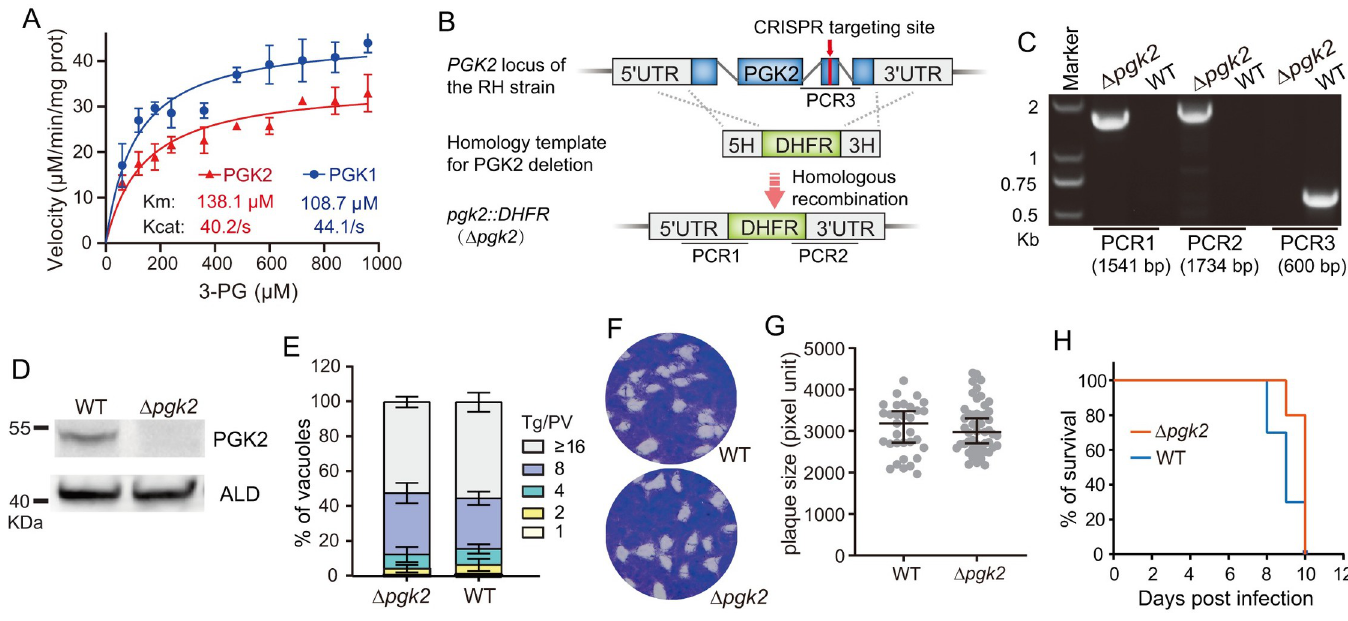
Fig 2. PGK2 is dispensable for T . gondii growth. A, comparison of the enzymatic activities of T . gondii PGK1 and PGK2, assayed with recombinant enzymes under different concentrations of 3-phosphoglycerate (3-PG). Means ± SD of three independent experiments were plotted. B, schematic illustration of PGK2 deletion by CRISPR/Cas9 directed homologous gene replacement with the selection marker DHFR . 5H and 3H denote the two homologous arms for recombination. PCR1/2/3 are amplification products for PGK2 deletion mutant ( Δ pgk2 ) identification. C, diagnostic PCR on a Δ pgk2 clone. D, Western blotting confirms the absence of PGK2 expression in the Δ pgk2 mutant. ALD was included as a loading control. E, comparison of the intracellular replication rates of the wildtype (WT) and the Δ pgk2 mutant, as determined by the distribution of the number (1, 2, 4, 8, � 16) of Toxoplasma parasite per PV (Tg/PV). Means ± SEM of three independent experiments, each with three replicates. More than 120 PVs were analyzed for each strain in each experiment. F, plaque formation of WT and Δ pgk2 parasites on HFF monolayers after 200 tachyzoites of each strain were used to infect HFF cells for 7 days. G, sizes of plaques derived from F, as expressed in pixel units when measured by Adobe Photoshop. H, survival curves of mice infected with WT or Δ pgk2 parasites. Each strain was tested by 10 mice.